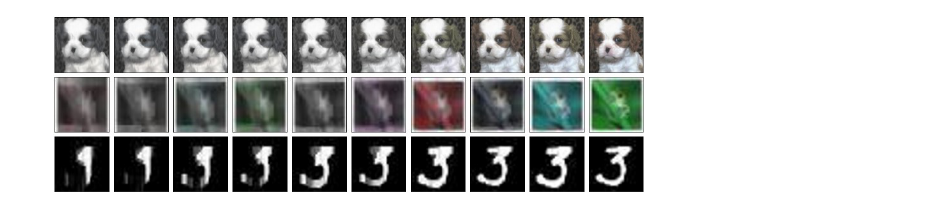
Figure 4. Examples of spatial-smoothing compression, sorted from left to right by window-size values, ranging from 10 to 1 (original image). ( Top ) images: from ImageNet, ( middle ): CIFAR10, and ( bottom ): MNIST.